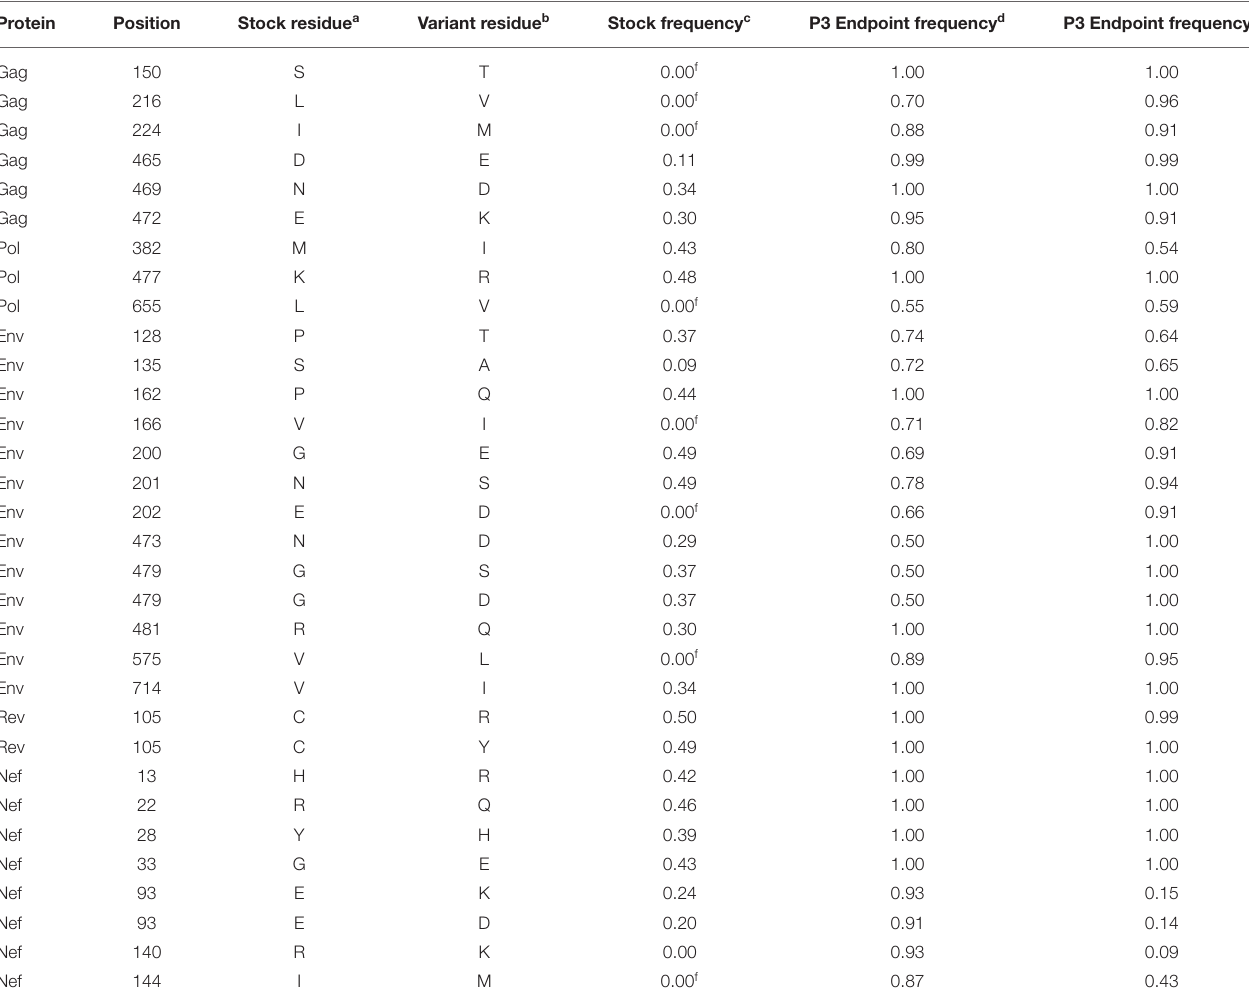
TABLE 2 | Amino acid substitutions accumulated during three passages of SIV B670 in hu-mice.